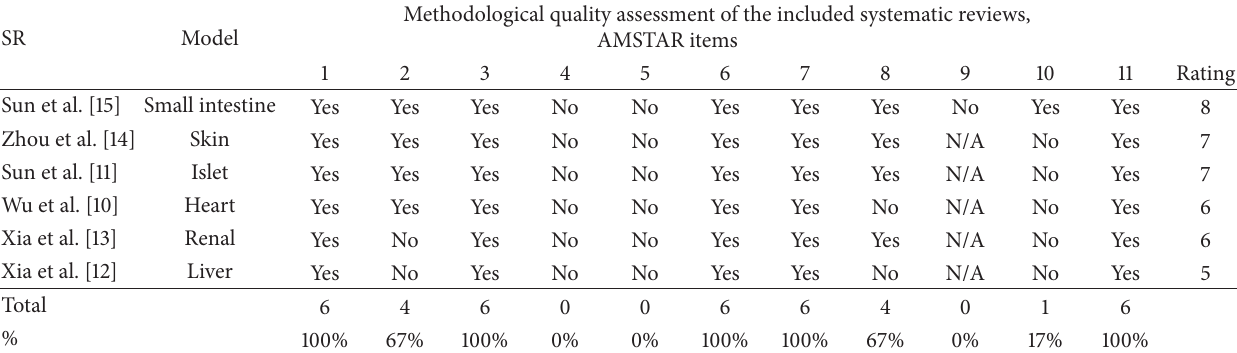
Table 2: Methodological quality assessment of systematic